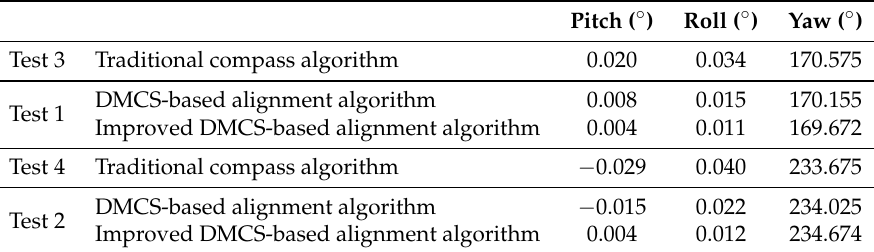
Table 3. Initial alignment results after 25 min.